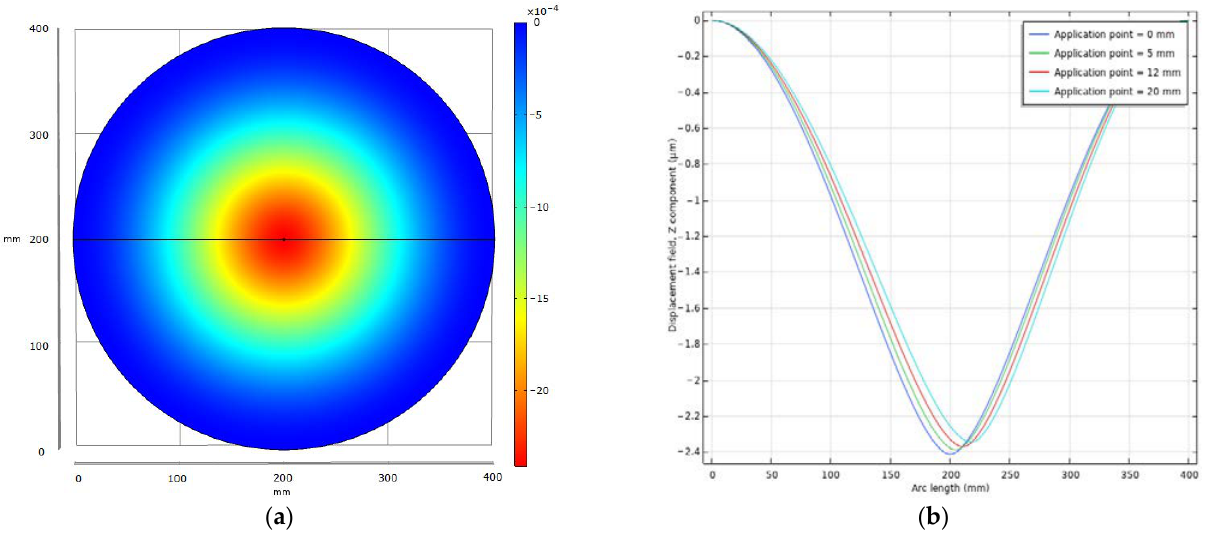
Figure 5. Deflection for light rain. ( a ) Top view of the plate with deflection as a colormap; ( b ) Deflection for different application points along the cross section of the plate.